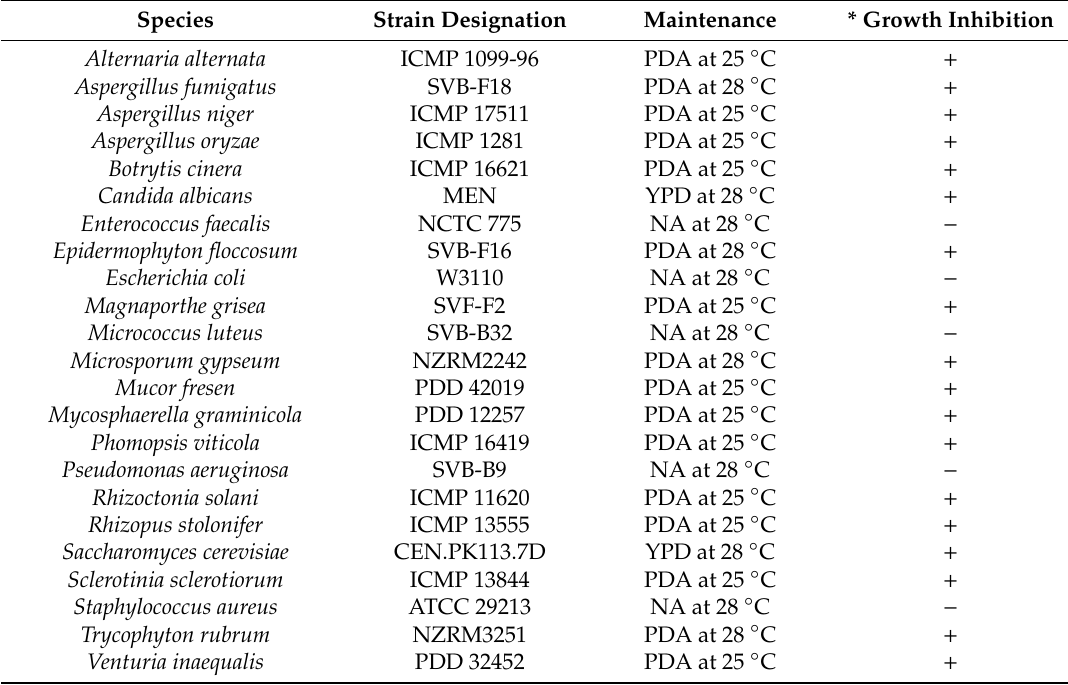
Table 2. Antimicrobial activity using disk di ff usion assays against epipyrone A disalt.